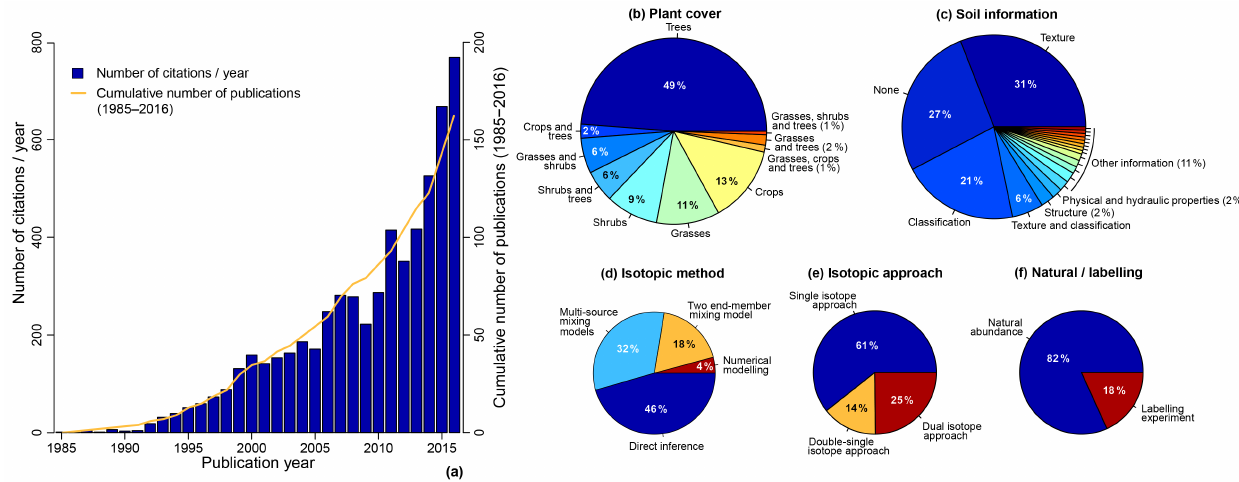
Figure 3. Results of the literature review when entering the search terms ((“root water uptake” or (“water source” and root) or “water uptake”) and isotop ∗ ) into the ISI Web of Science search engine (www.webofknowledge.com). (a) Evolution of the number of citations per year and cumulative number of publications from 1985 to 2016; (b) details are given on the plant cover; (c) the available soil information; (d) the applied isotopic method and (e) approach; and the type of experiment (f)